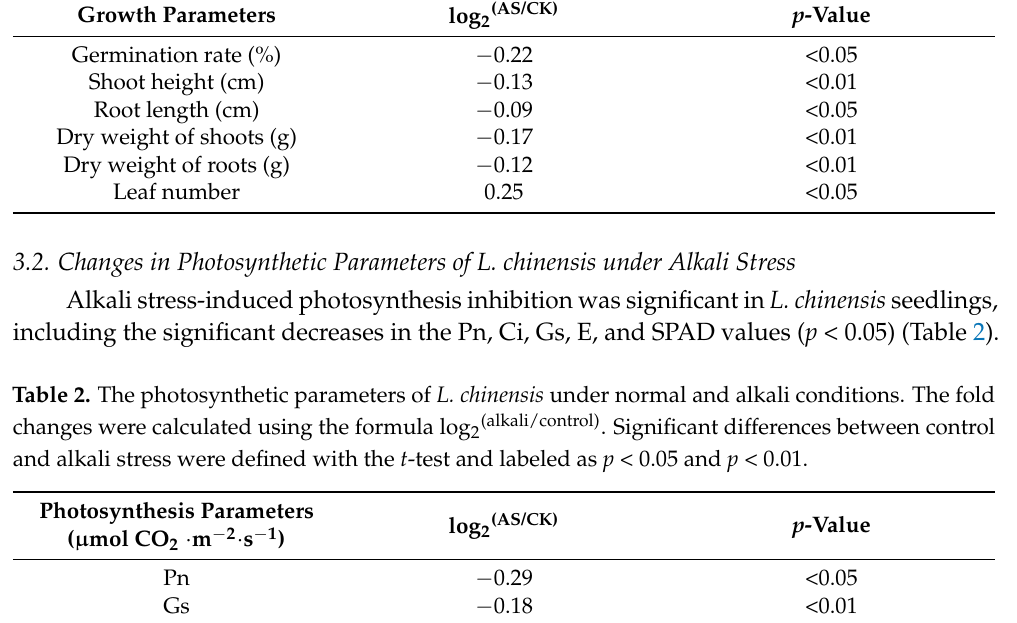
Table 1. The growth parameters of L. chinensis under normal and alkali conditions. The germination rate was calculated using the formula (the number of seedlings per pot / 30) × 100%. The fold changes were calculated using the formula log 2(alkali/control) . Significant differences between control and alkali stress were defined with the t -test and labeled as p < 0.05 and p < 0.01. Growth Parameters log 2(AS/CK)